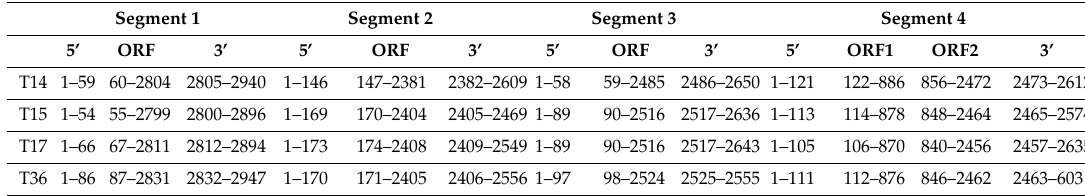
Table 2. Organization of the JMTV genomes characterized in the